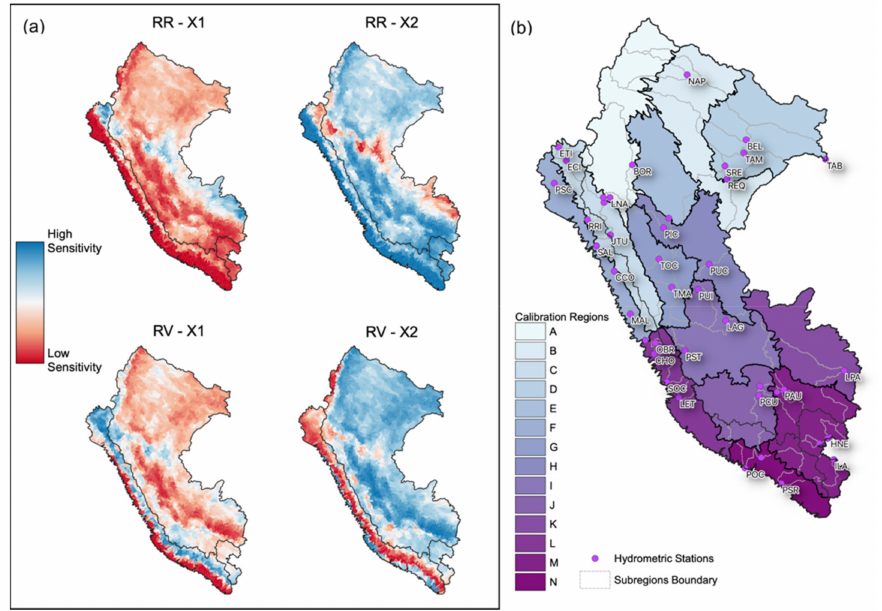
Figure 5. ( a ) Relative sensitivities of RR and RV indices obtained from FAST. ( b ) Delimited calibration regions and sub-regions for the GR2M model at a national level, each region contains at least one hydrometric